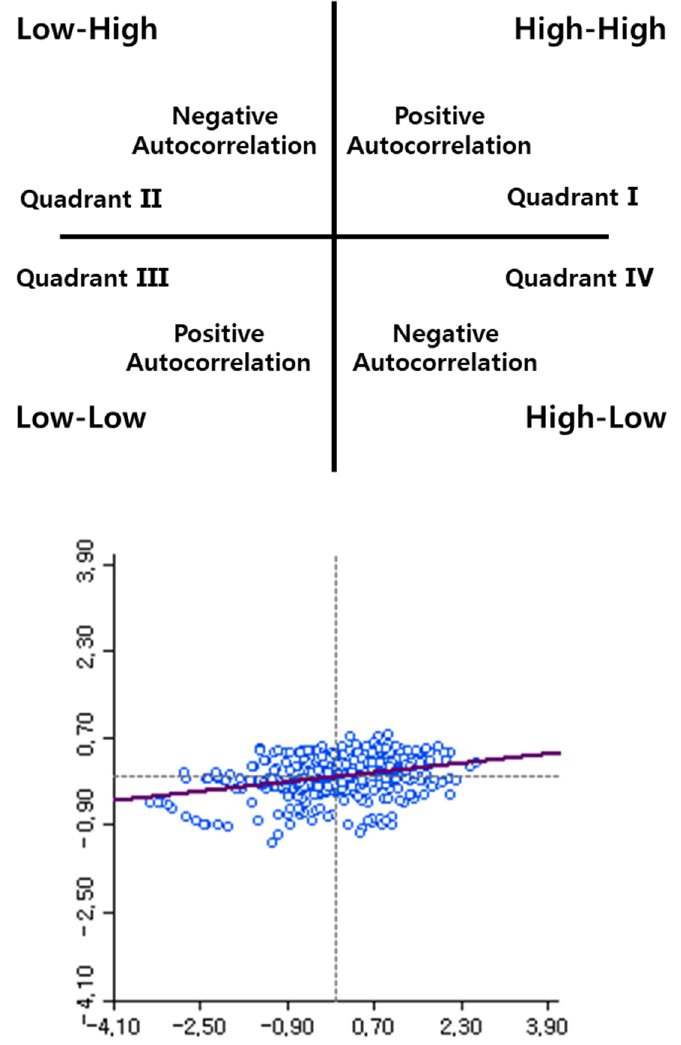
Figure 6. The scatterplot showing the relationship between the variables corresponding to the observed point and spatial lag ( upper ). An example of a scatterplot ( lower ). The x -axis and y -axis are representative of the observed crop growth status of one individual, and spatial lag calculated by Equation (1). This scatterplot was made from all observed individual crop growth statuses.